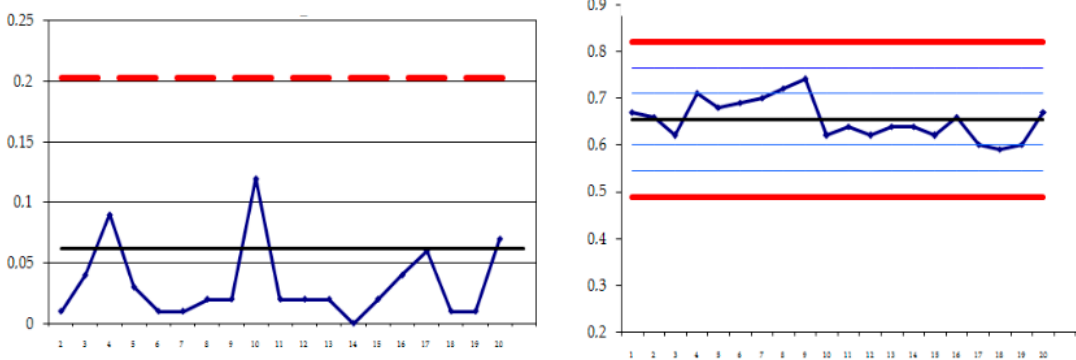
Figure 2. Shewhart’s control charts for the fixed asset index (author’s study).